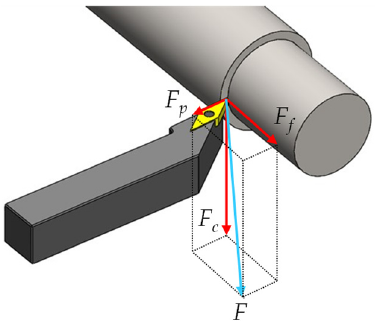
Figure 1. The schematic diagram of the cutting force in longitudinal turning.